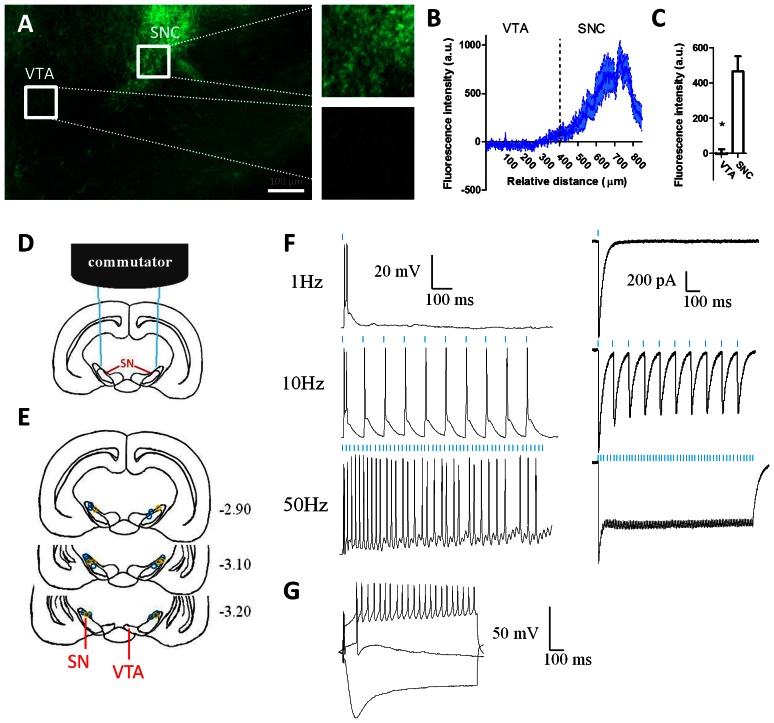
ChR2 expression in substantia nigra dopamine neurons.(A) ChR2 was limited to the SNC with no expression in the neighboring VTA. Fluorescence intensity (with background subtracted) was calculated along a line through the VTA and SNC. Scale bar is 100 µm. (B) Average (± s.e.m.; 8 mice) normalized fluorescence values along the extent of the line from VTA to SNC. (C) Average intensity values from VTA and SNC (n = 8, p<0.001). (D) Schematic representation showing two implanted optic fibers targeting the SN connected to a rotating commutator. (E) The location of injection sites is shown for ChR2 mice (blue circles; n = 8) and YFP controls (yellow circles; n = 4). The numbers indicate the anterior-posterior location (mm from Bregma). (F) In vitro stimulation of DA neurons. Current-clamp recordings (left column) from a ChR2-expressing dopamine neuron in the substantia nigra: 10-ms pulses of 470-nm light (blue lines) elicit frequency-dependent spiking at 1-Hz, 10-Hz, and 50-Hz. In voltage-clamp recordings (right column), light pulses induce inward currents in ChR2-expressing dopamine neurons. (G) Current injection experiments showed a sag in response to hyperpolarizing current indicating a hyperpolarization activated current (Ih), characteristic of SNC DA neurons.